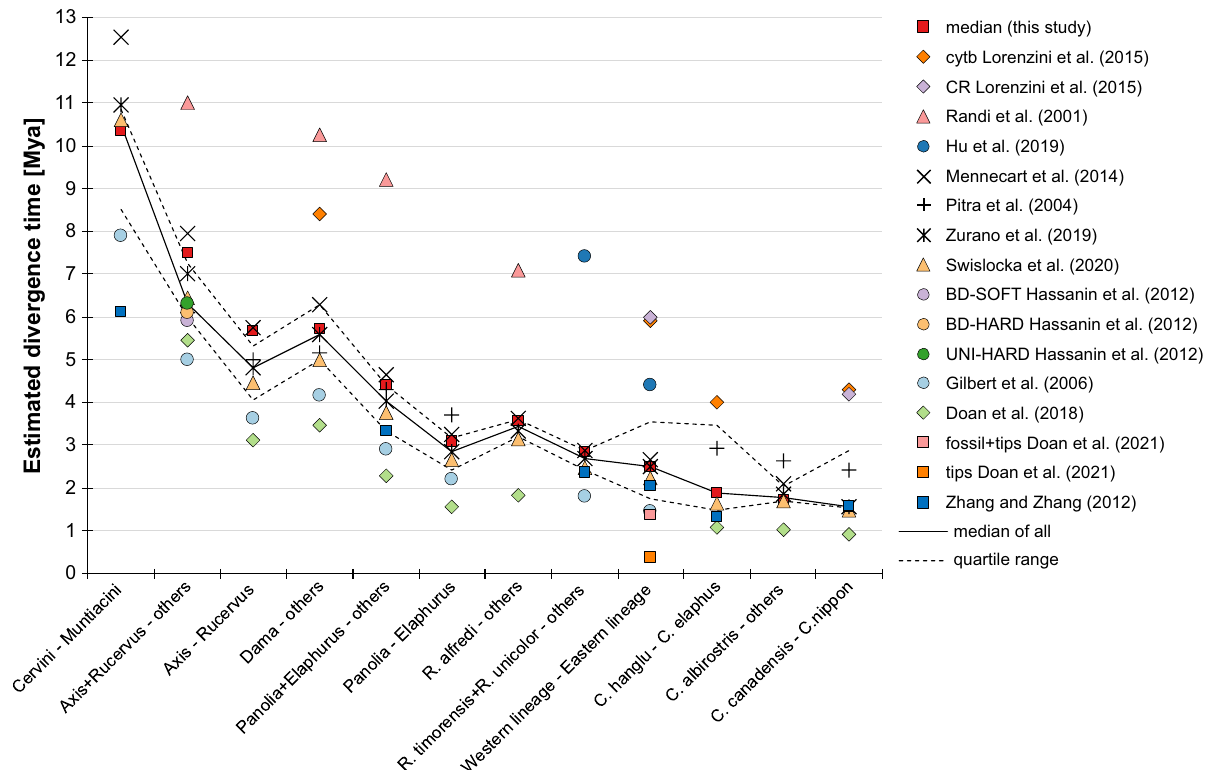
Figure 8. Comparison of selected divergence times of and within Cervini obtained in this study with those of previous analyses. BD-SOFT, BD-HARD and UNI-HARD indicate models with different priors uniform (UNI) and birth–death (BD) on divergence times, combined with either hard or soft fossil calibrations 31